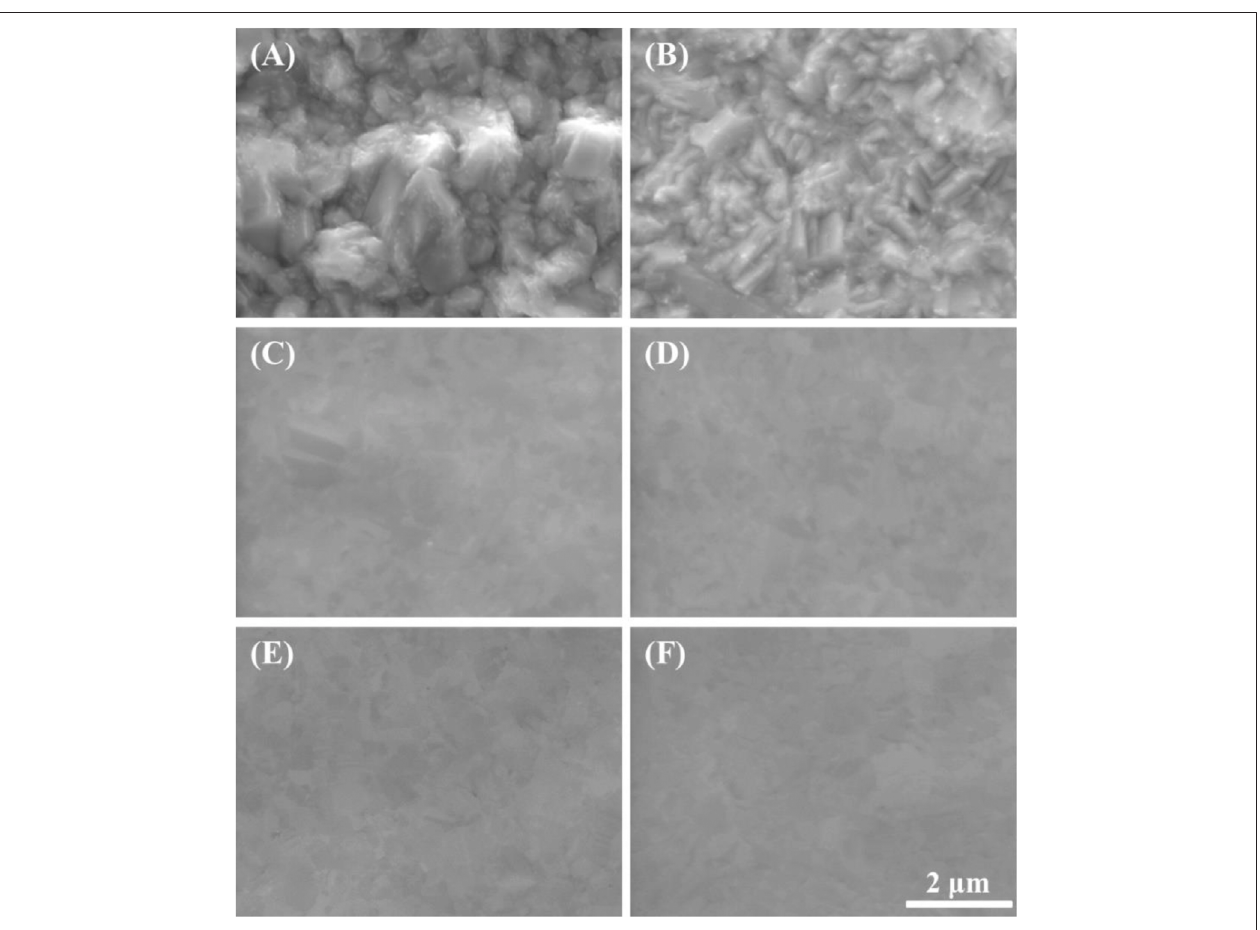
FIGURE 4 | SEM images of anodically polarized Cu substrates in 85% phosphoric acid at various potentials with a charge density of 2.5 C/cm 2 : (A) before polarized, (B) 0.25 V, (C) 0.375 V, (D) 0.50 V, (E) 0.90 V, and (F) 1.30 V.